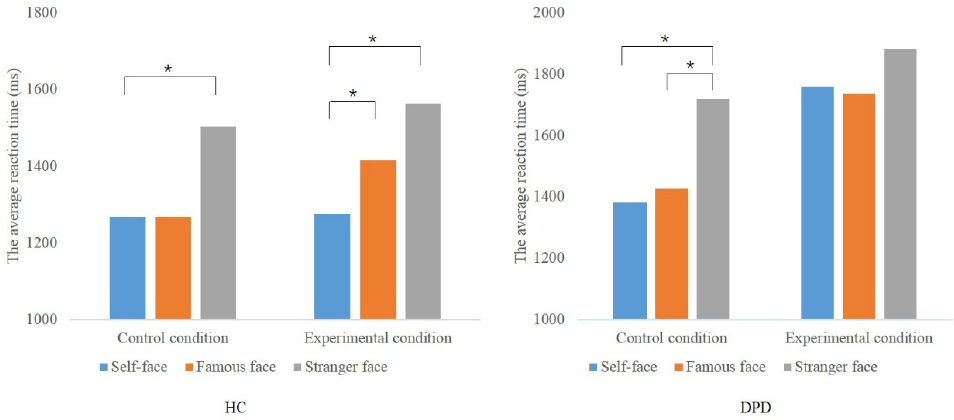
Figure 3. The reaction times to the self-face, famous faces and strangers’ faces for the HC and DPD, for the control and experimental conditions; HC: Healthy controls; DPD: Depersonalization/derealization disorder; * p < 0.05.